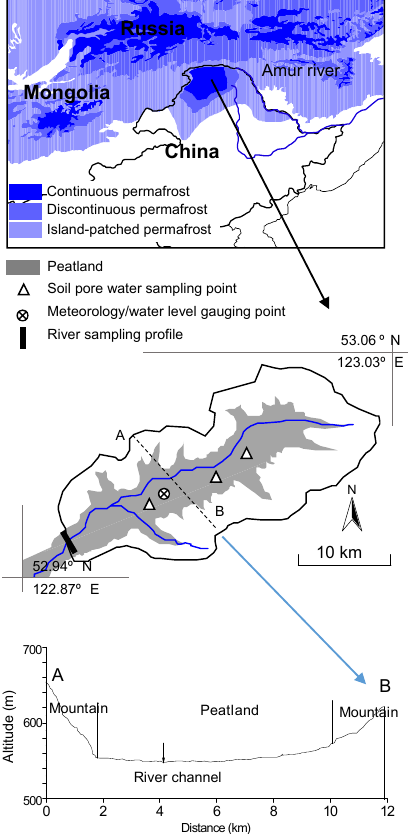
Figure 1. Geographic location of the study